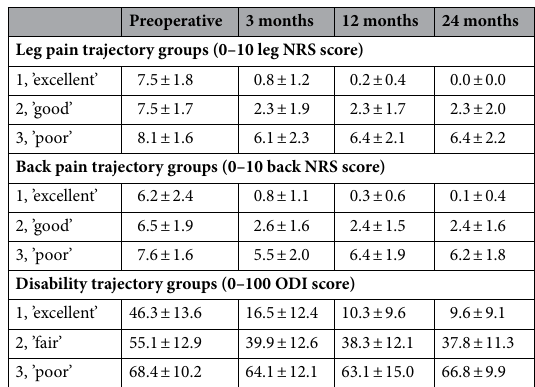
Table 3. Scores for clinical outcomes according to trajectory group across time. Values are mean ± SD. NRS numeric rating scale, ODI modified Oswestry disability index.